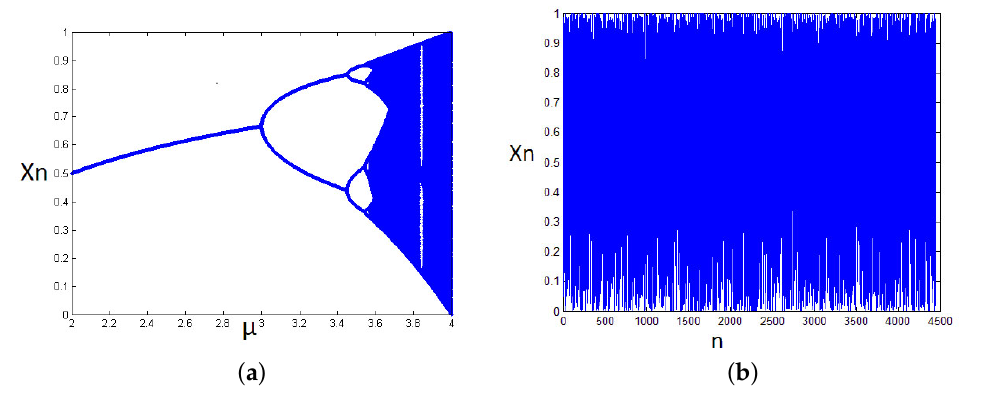
Figure 4. ( a ) The bifurcation diagram. ( b ) Invariant natural